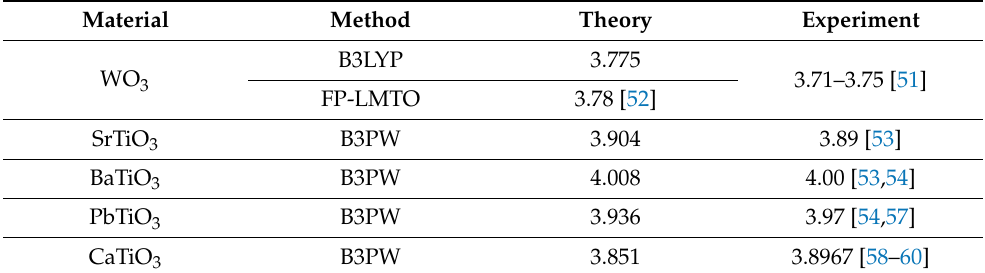
Table 2. Our ab initio-calculated and experimentally measured WO 3 , SrTiO 3 , BaTiO 3 , PbTiO 3 and CaTiO 3 bulk lattice constants